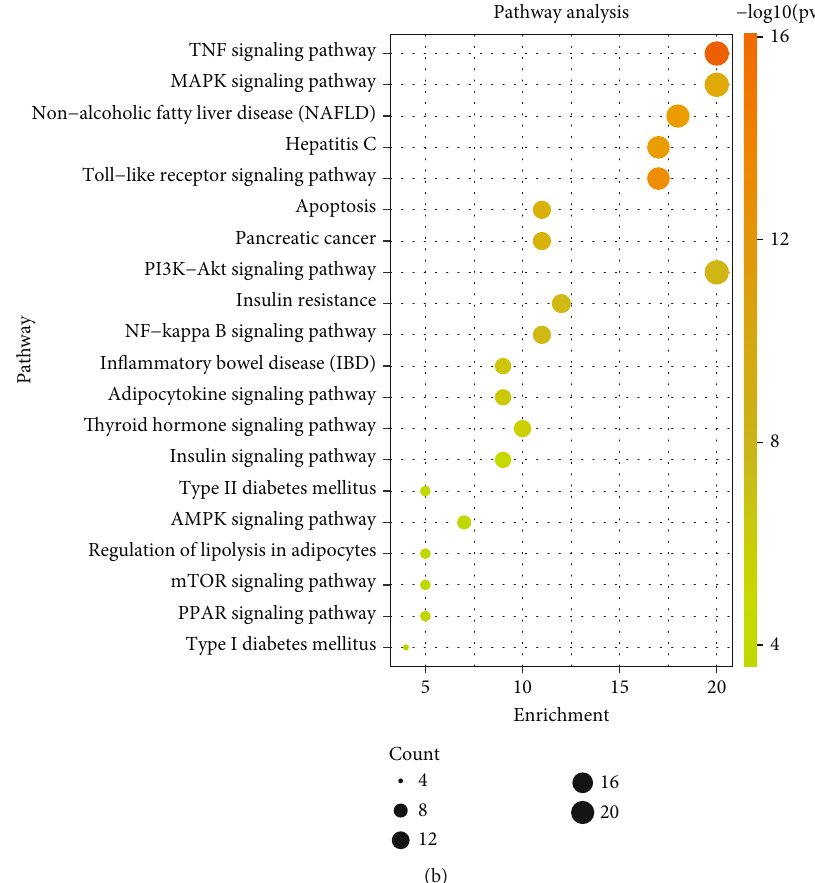
Figure 4: Overlapped term-based analysis. (a) GO enrichment analysis for the major targets of AMB against NAFLD. The green, orange, and purple color rectangles represent biological process (BP), cellular component (CC), and molecular function (MF), respectively. (b) The top 20 KEGG pathway analysis for the major targets of AMB against